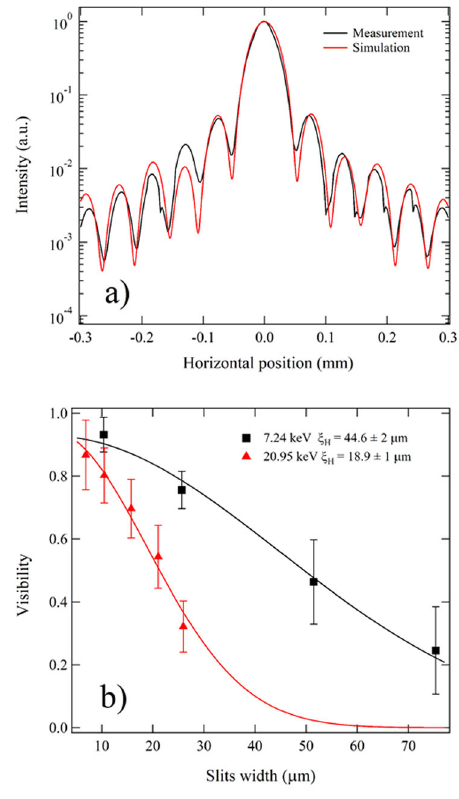
Fig. 6 Fraunhofer diffraction patterns. a Fraunhofer diffraction from a single pair of slits with opening 25 × 25 μ m 2 , measured (Measurement, black line) and calculated (Simulation, red line) at beamline ID10. Primary slits: 0.2 × 0.2 mm 2 at 27 m, asymmetrical slits 95 at 60 m and detector at 7.8 m from the slits, photon energy: 7.24 keV, detector slits 5 × 5 μ m 2 . The pattern is normalised to the peak value. b Fringe visibility of Fraunhofer diffraction patterns as a function of the horizontal slits ’ width (markers: measurements, lines: fi t). The horizontal coherence length ξ H at 60 m was estimated with V ¼ exp ð(cid:2) a 2 = 2 ξ H 2 Þ were a is the slit aperture 96 . The estimates for the horizontal coherence length from a Gauss-Schell model 97 are ξ H ¼ 53 : 4 μ m at 7.24 keV and ξ H ¼ 19 : 1 μ m at 20.95 keV. The error bars are given by the he standard deviation of the visibility values for each slits